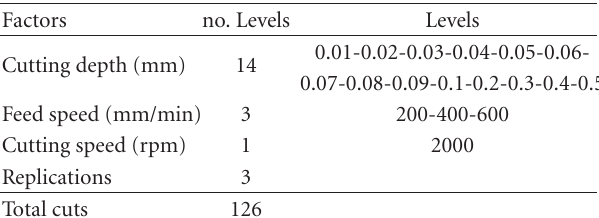
Table 3: Experimental plan.